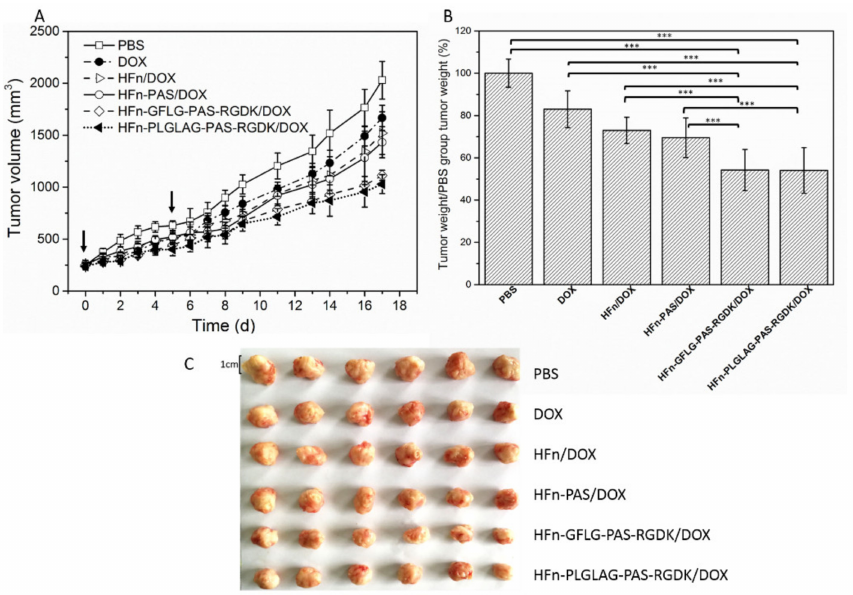
Figure 7. In vivo tumor inhibitory effects on 4T1 tumor-bearing mice. ( A ), tumor volume change over time. ( B ), group tumor weight/ PBS group tumor weight (%) on day 17. *** p < 0.001. Symbol ‘*’ represents the significance of p value between groups. ( C ), the photo of excised tumor tissues on day 17. Arrows indicated the injection days; data are mean ± RSD ( n =